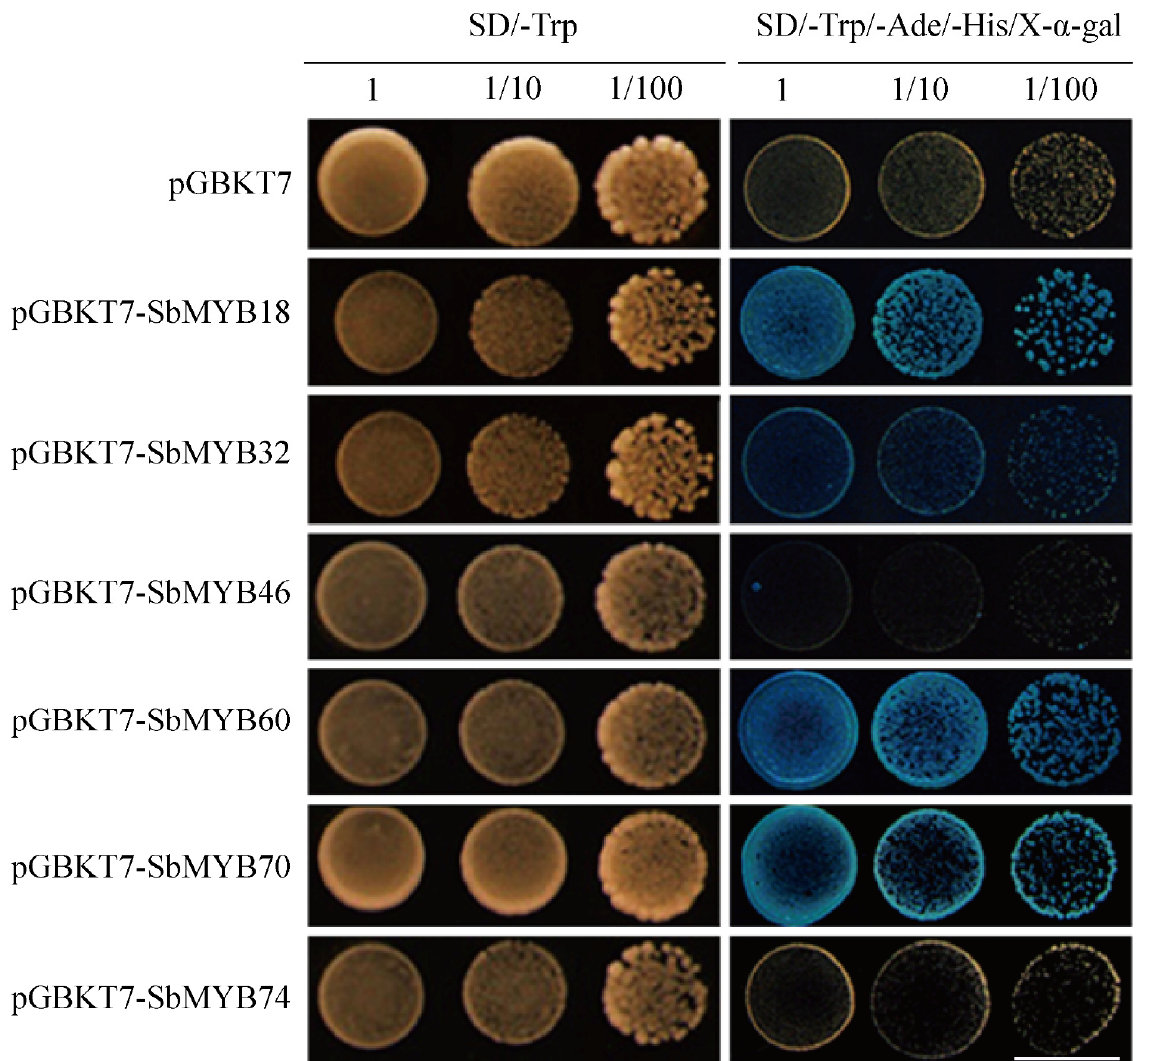
Figure 13. Transactivation activity of Sb MYBs protein. The construct of the six recombinant vector pGBKT7- Sb MYBs were transformed into AH109 and detected on SD/-Trp, SD/-Trp/-His/-Ade medium with X- α -gal. (Scale bar: 8mm)